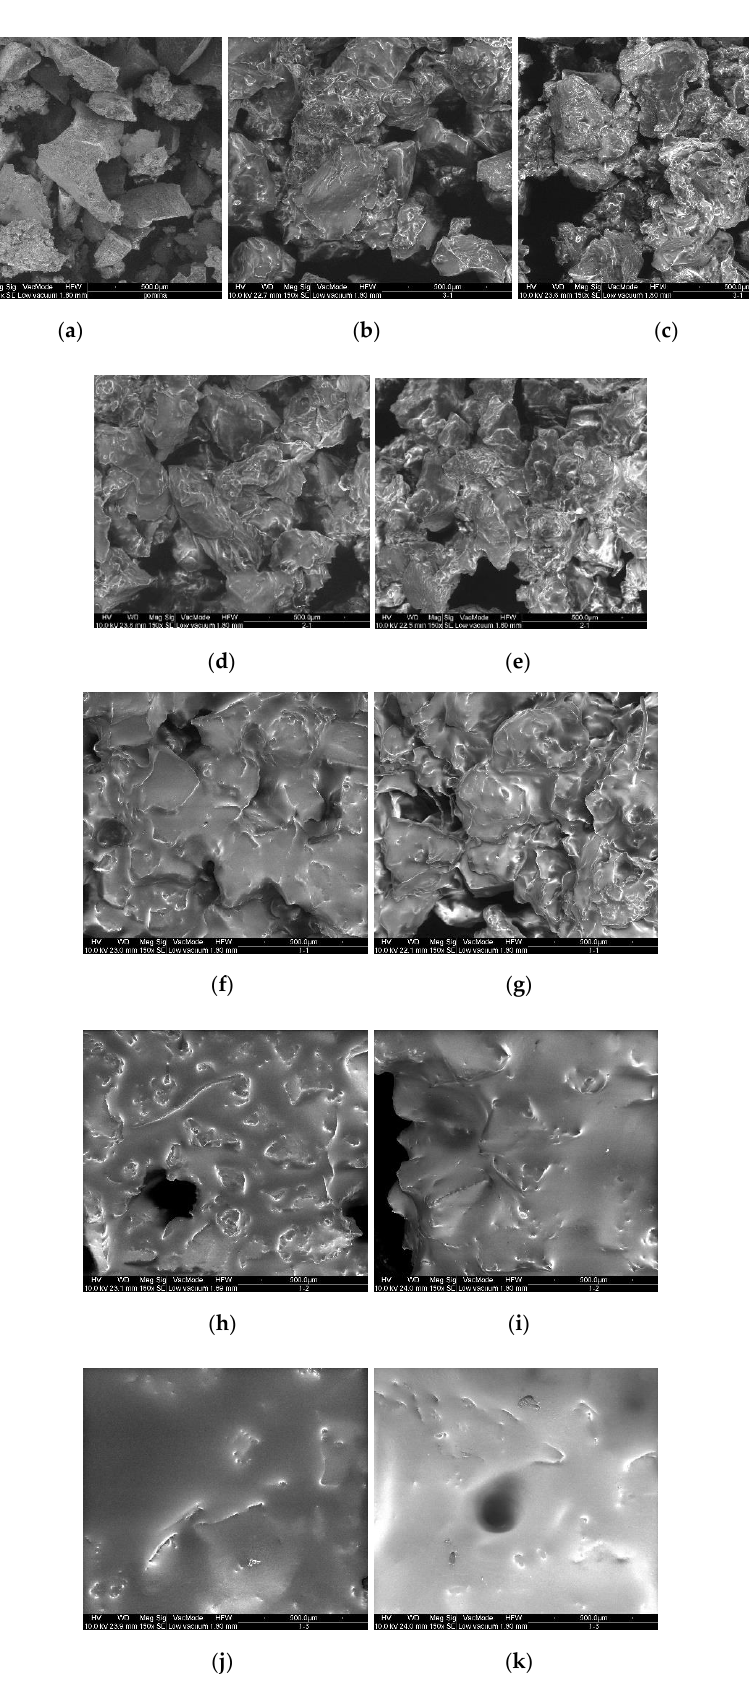
Figure 3. Rubber and extenders images acquired by scanning electron microscope with a magnitude of about 150x. ( a ) R; ( b ) R:O1 = 3:1; ( c ) R:O2 = 3:1; ( d ) R:O1 = 2:1; ( e ) R:O2 = 2:1; ( f ) R:O1 = 1:1; ( g ) R:O2 = 1:1; ( h ) R:O1 = 1:2; ( i ) R:O2 = 1:2; ( j ) R:O1 = 1:3; ( k ) R:O2 = 1:3.